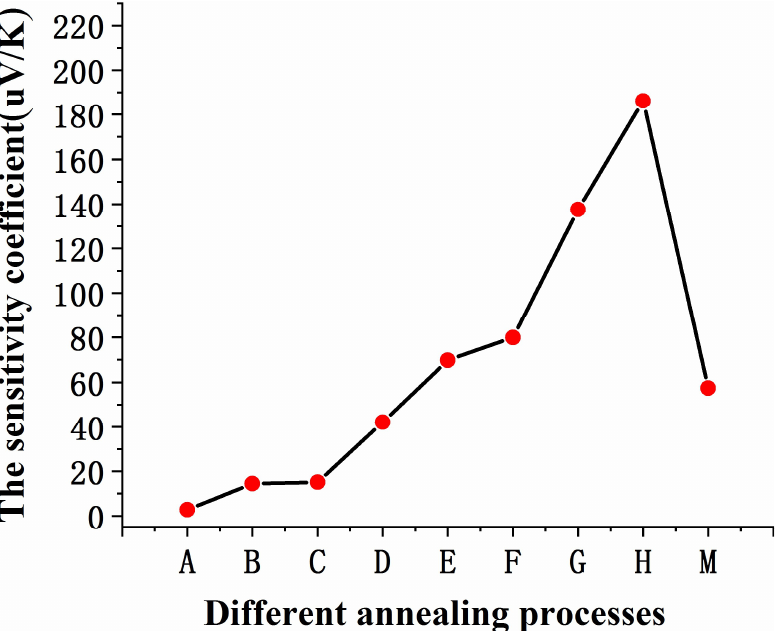
Figure 13. Average sensitivity coefficients of TFTCs at different annealing processes. (A: No annealing. B: 600 °C in air for 2 h. C: 1000 °C in air for 2 h. D: 600 °C with vacuum. E: 1000 °C with vacuum. F: 1000 °C in air for 4 h. G: 1000 °C in air for 6 h. H: 1000 °C in air for 8 h. M: 1000 °C in air for 10 h.).